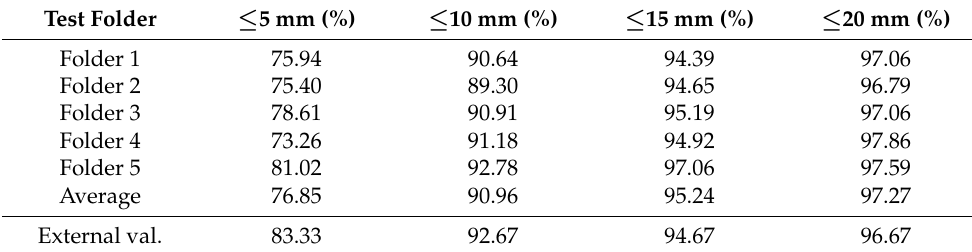
Table 7. The object error distribution in ETT tip.